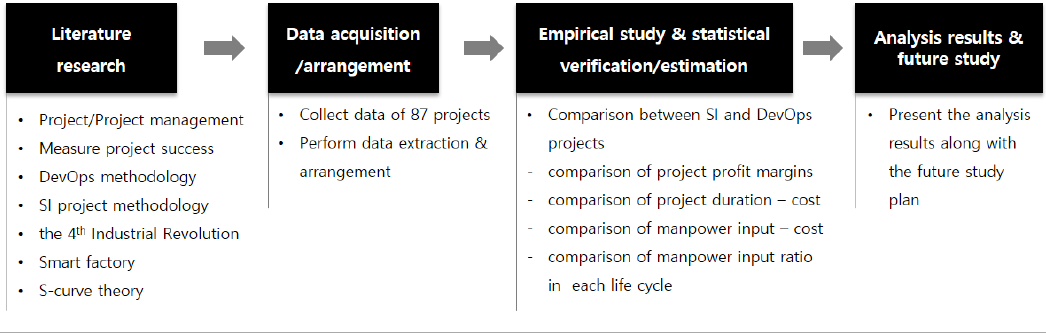
Figure 10. The Research Model.